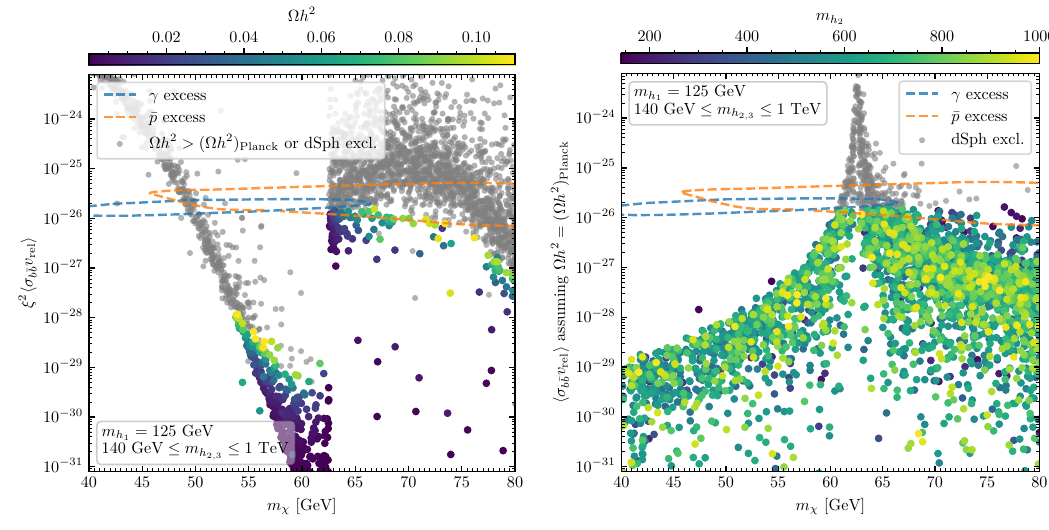
Figure 5 . Today’s velocity averaged annihilation cross section of χ into pairs of b quarks taking into account the number density as predicted by thermal freeze-out (left) and assuming Ω h 2 = 0 . 119 (right). The colour coding indicates the predicted value of Ω h 2 (left) and the value of m h Also indicated are the regions in which the cosmic-rays excesses could be explained within the 2 σ confidence level (blue and orange dashed lines) [25, 66]. Grey points are excluded by Ω h 2 > (Ω h 2 (left) or Fermi dSph measurements (left and